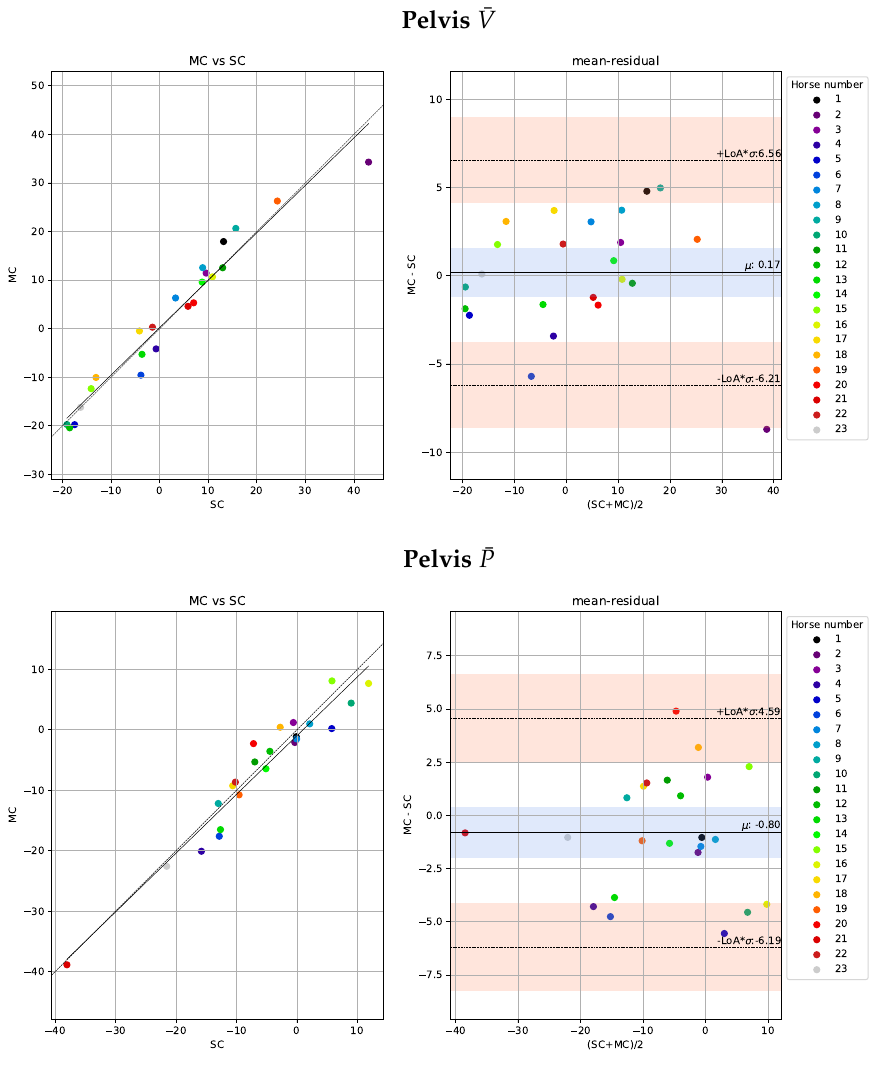
Figure 10. Trial-level scatter plots of the pelvic metrics from the 23 included horses measured by the marker-based motion capture system (MC) versus the single-camera markerless system (SC) are presented in the left panel. Agreements between the systems, with limits of agreement (LoA) displayed as orange horizontal lines, are presented in the Bland-Altman plots in the right sub- panels.In the top, we show ∆ ¯ V (trial mean MinDiff) and in the bottom row, we show ∆ ¯ P (trial mean MaxDiff) defined in Section